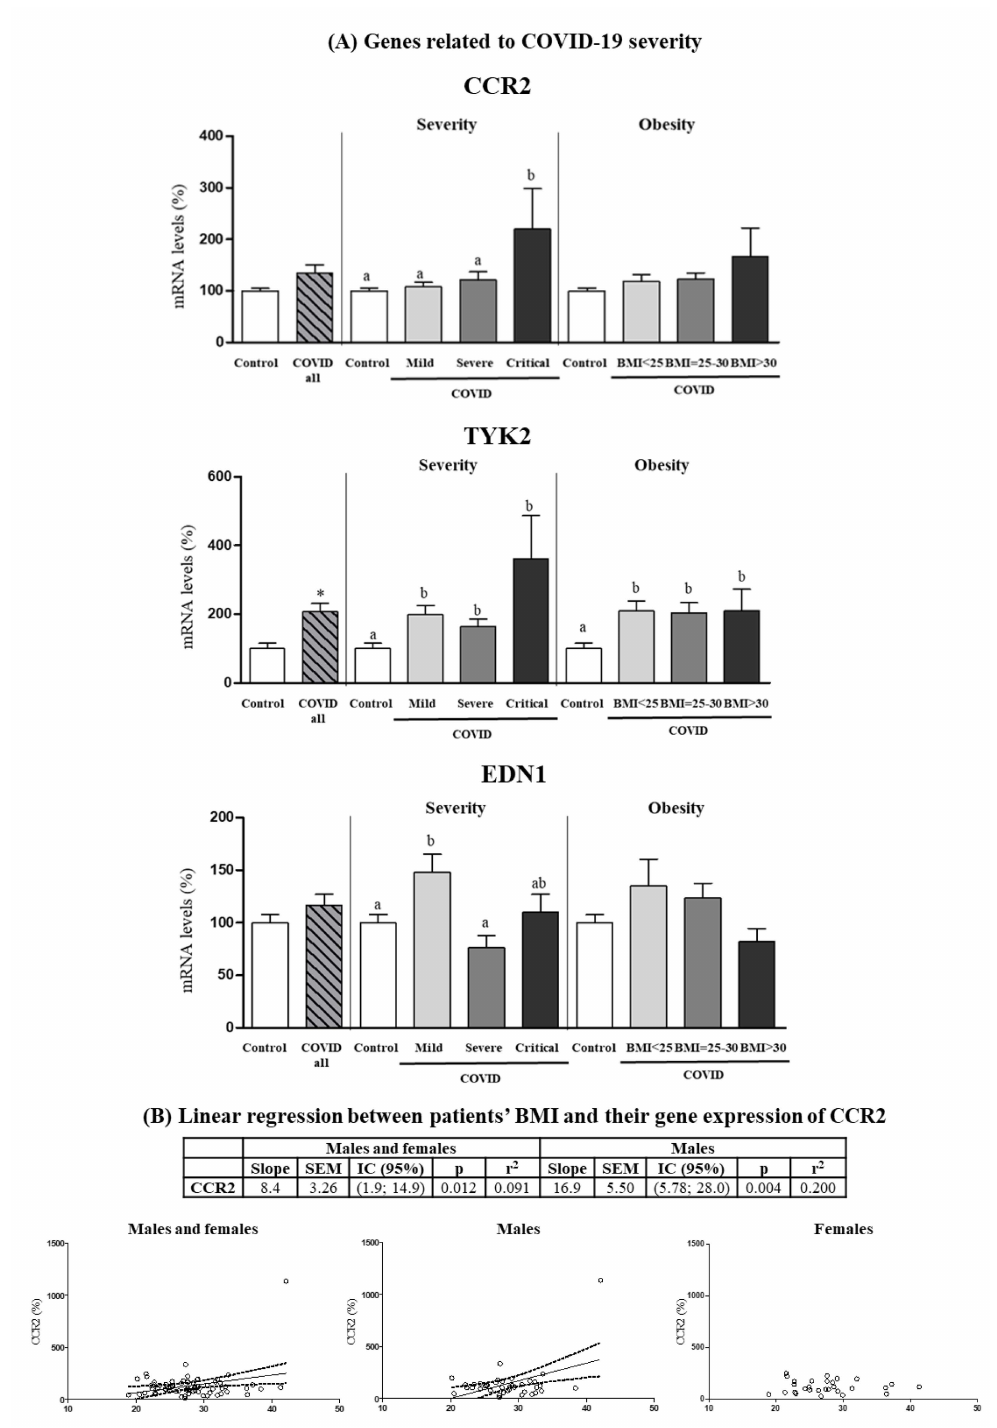
Figure 5. ( A ) Expression levels in PBCs of the indicated genes related to COVID severity in con- trol subjects and COVID-19 patients (all) and separated according to COVID severity and obesity. ( B ) Linear regression between patients’ BMI and their gene expression in PBCs of CCR2 . mRNA levels were measured by real-time qPCR and expressed as a percentage of the value of Control (male and female). Data are expressed as the mean ± SEM. Statistics: differences between stratified groups were analyzed by one-way ANOVA followed by least significant difference (LSD) post-hoc test, a (cid:54) = b ( p < 0.05). Student’s t test was used for single comparisons: *, COVID all vs